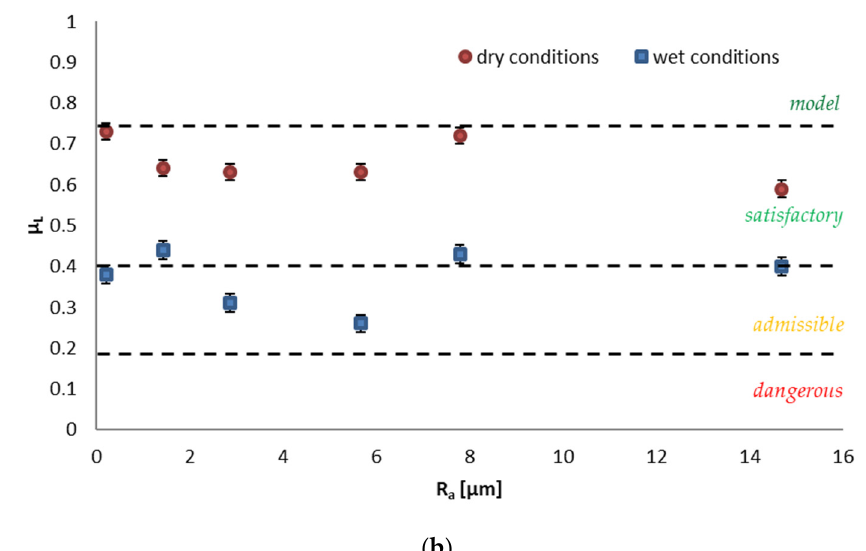
Figure 7. The sliding friction coefficient test results classification according to Nemire et al. [3] and Bellopede et al. [31] depending on the roughness of surface for ( a ) rubber sliders and ( b ) leather sliders in wet and dry conditions.